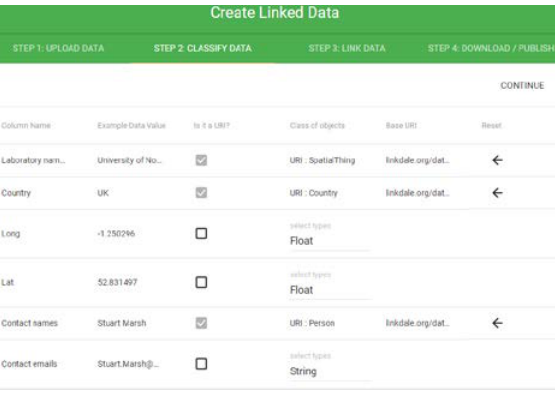
Figure 2. View of the classification step where users are asked